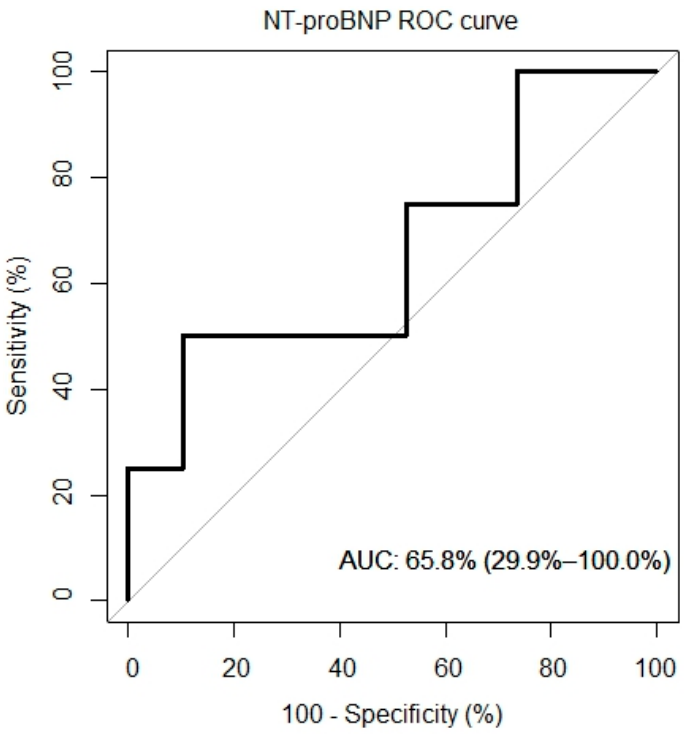
Figure 5. ROC curves of peak VO2, VE/VCO2 and overall survival.